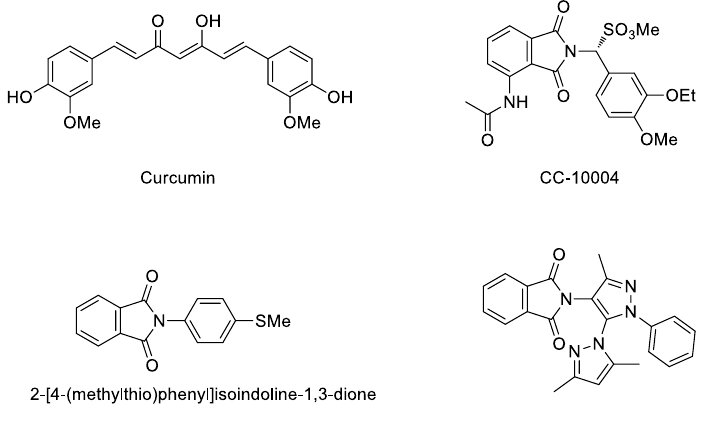
Figure 1. The chemical structures of curcumin, CC-10004, 2-[4-(methyl-thio)phenyl] isoindoline-1,3-dione, and